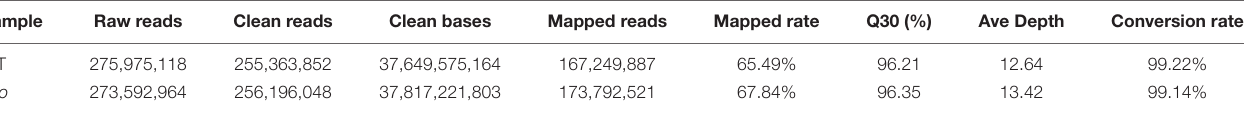
TABLE 1 | Summary of genome-wide methylation sequencing